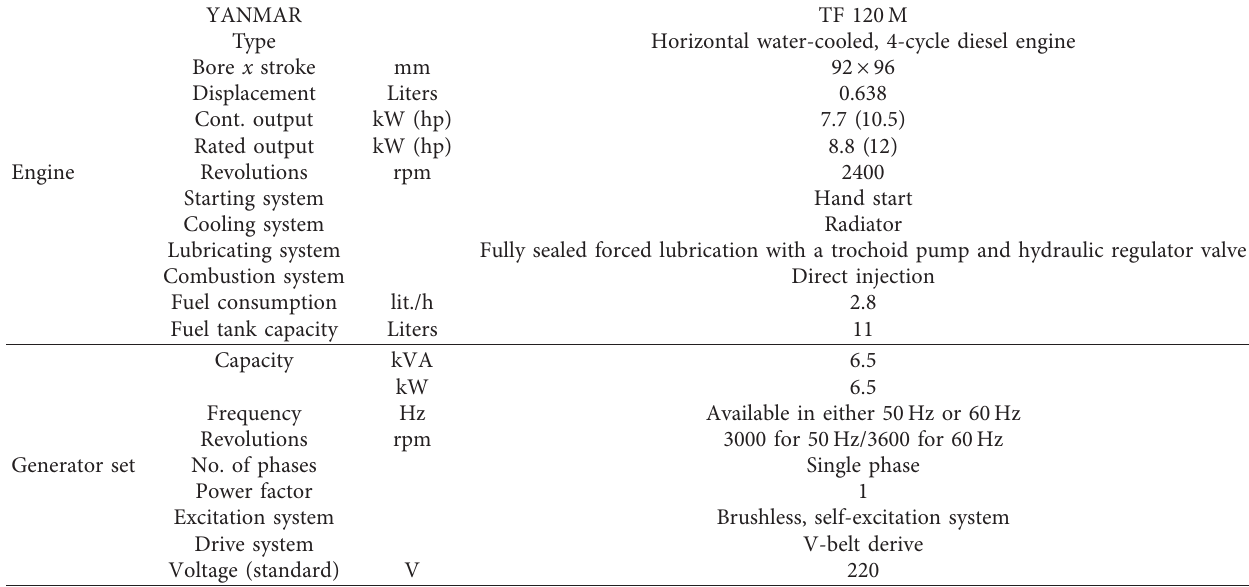
Table 1: Information of the engine and generator used in this